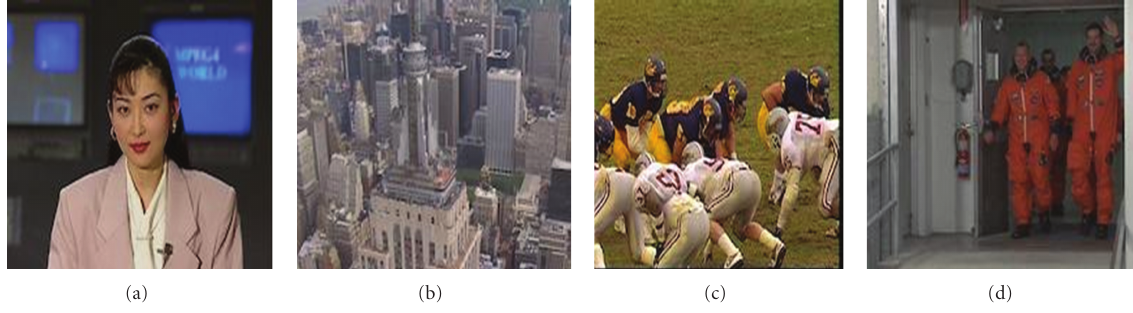
Figure 4: Screen shots of standard videos Akiyo , City , Football , and Crew.